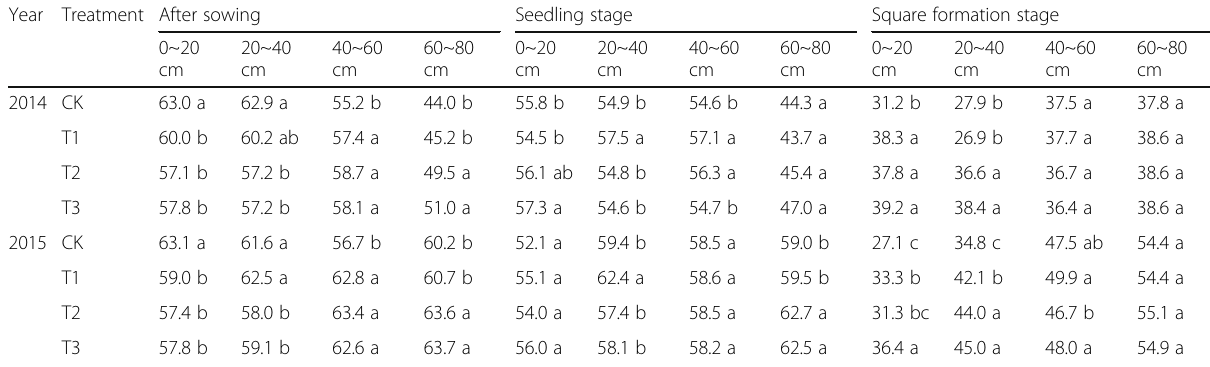
Table 1 Soil water stored in different soil layers after the sowing, seedling, and square formation stages of cotton in 2014 and 2015 (mm) Year Treatment After sowing Seedling stage Square formation stage